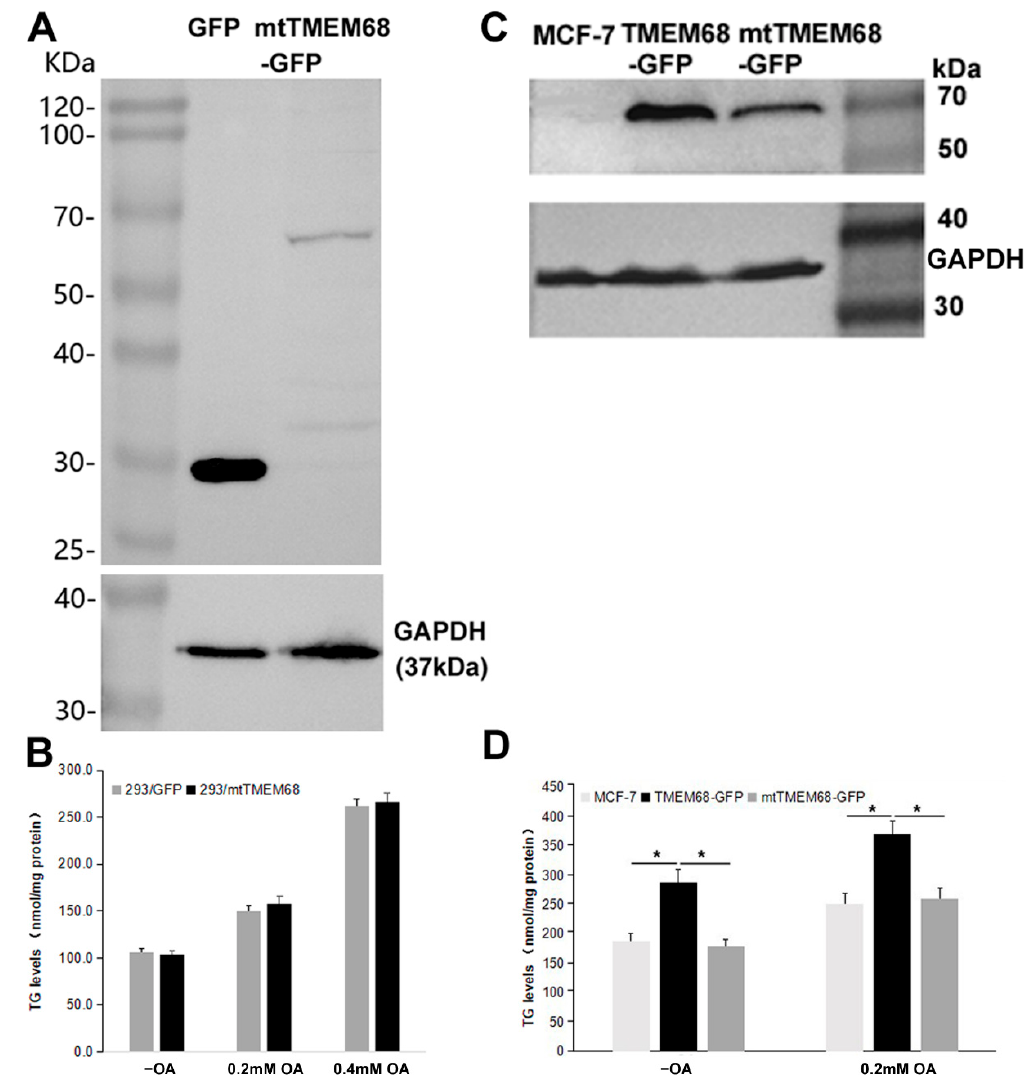
Figure 2. TG accumulation induced by TMEM68 overexpression depends on the conserved catalytic motif. A and C, the expression of GFP, TMEM68-GFP, mtTMEM68-GFP in HEK 293 ( A ) and MCF-7 ( C ) cells was detected by western blotting using an anti-GFP antibody. The expression of GAPDH was detected as the loading control and migration of molecular mass standard proteins is indicated. B and D, TG levels were quantified in HEK 293 ( B ) and MCF-7 ( D ) cells that transiently expressed GFP, TMEM68-GFP or mtTMEM68 cells in the absence or presence of OA for 12 h. Data is presented as means ± SD. Asterisk indicates p values: * p < 0.05, n =